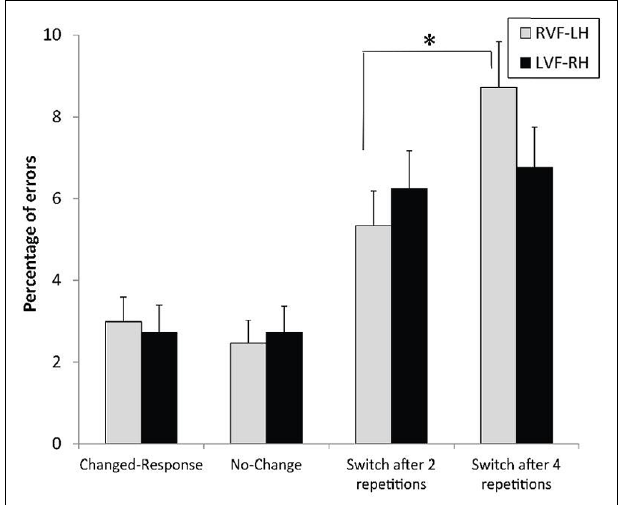
FIGURE 6 | Mean error rates and standard errors, according to the context preceding the experimental trial and the visual field of presentation . * p <